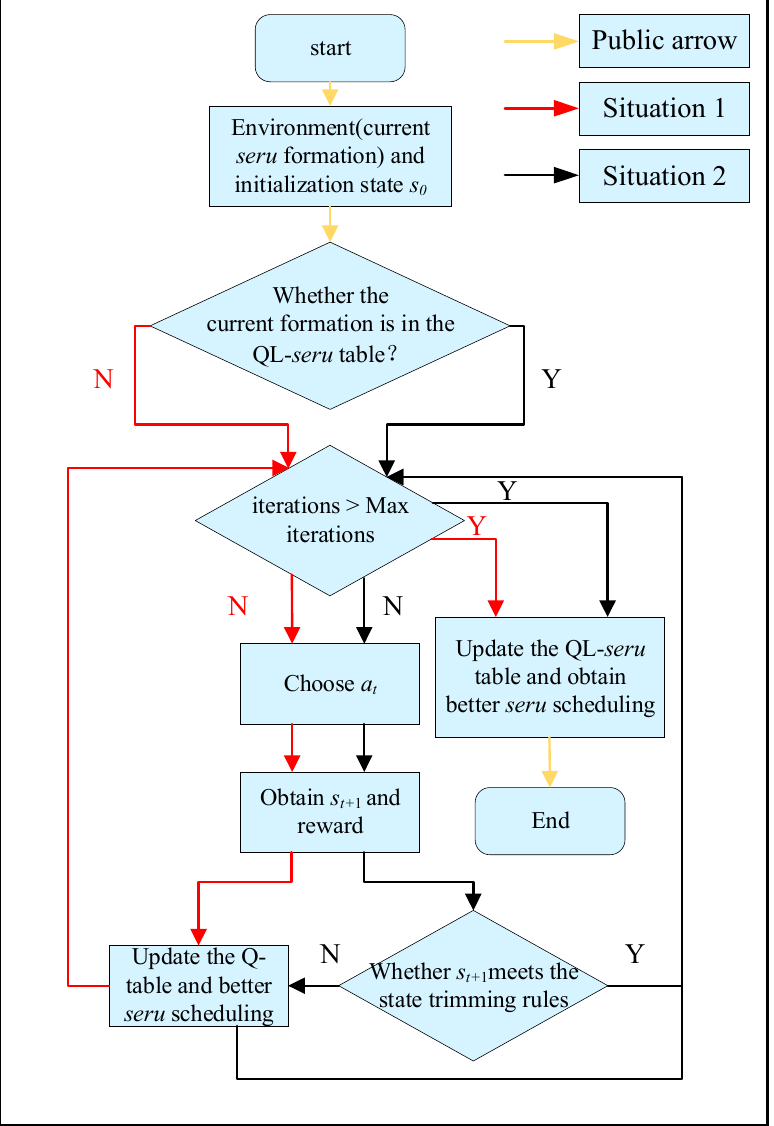
Fig. 7. Flowchart of QL- seru algorithm